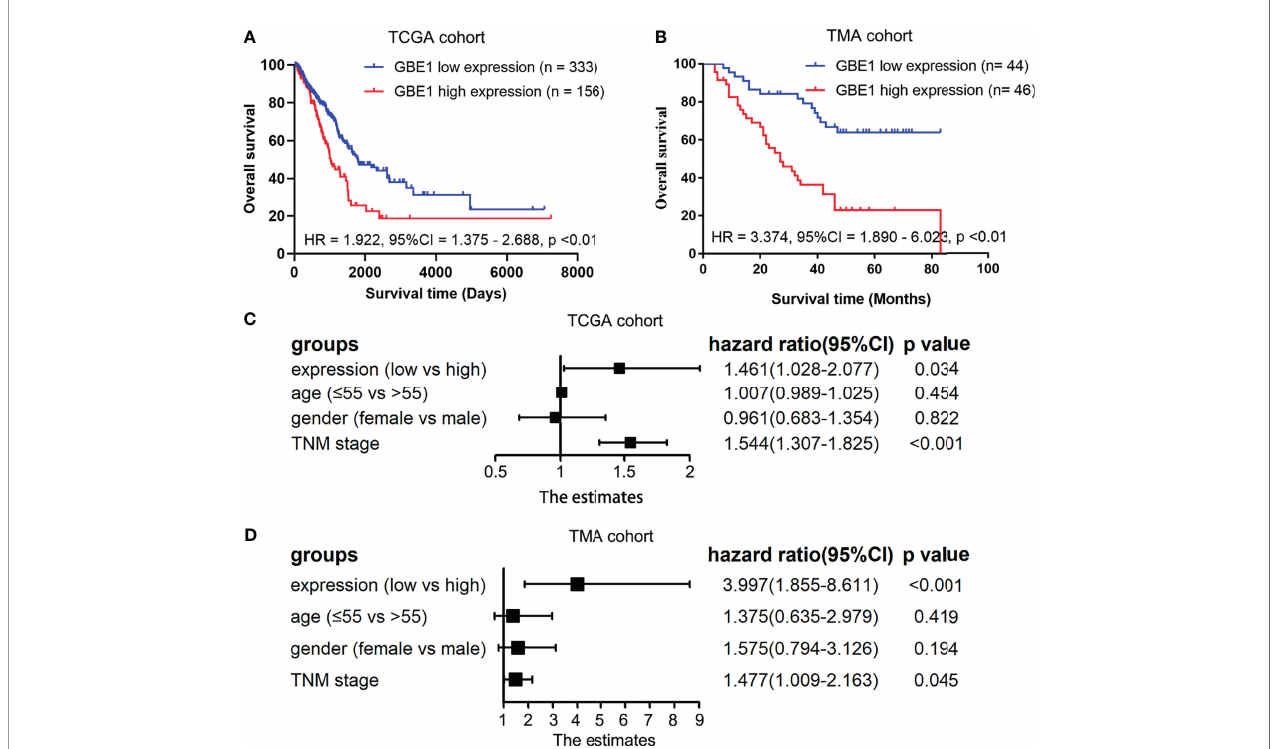
FIGURE 3 | The correlations between GBE1 expression and prognosis in LUAD and the multivariable Cox regression analysis by utilizing the TCGA cohort and TMA cohort (A – D) . (A) The Kaplan-Meier survival curve comparing the high and low expression of GBE1 in TCGA cohort. (B) The Kaplan-Meier survival curve comparing the high and low expression of GBE1 in the TMA cohort. (C) The multivariable Cox regression analysis of different expression of GBE1 in TCGA cohort. (D) The multivariable Cox regression analysis of different expression of GBE1 in the TMA